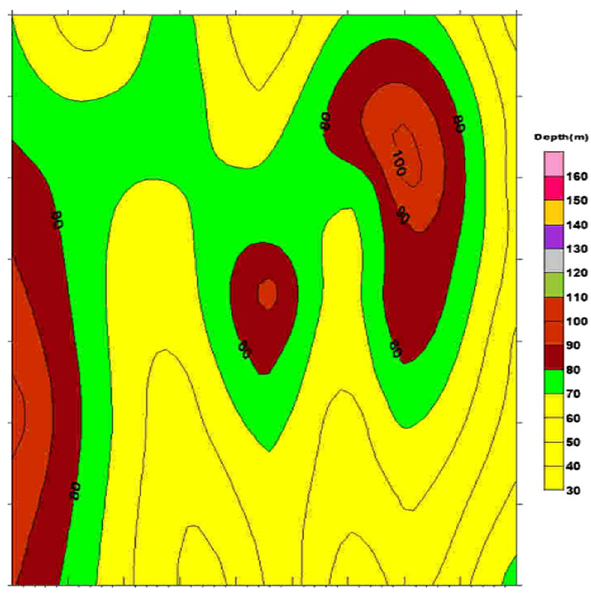
Fig. 6 Depth to the top of the saltwater–freshwater interface map in the study